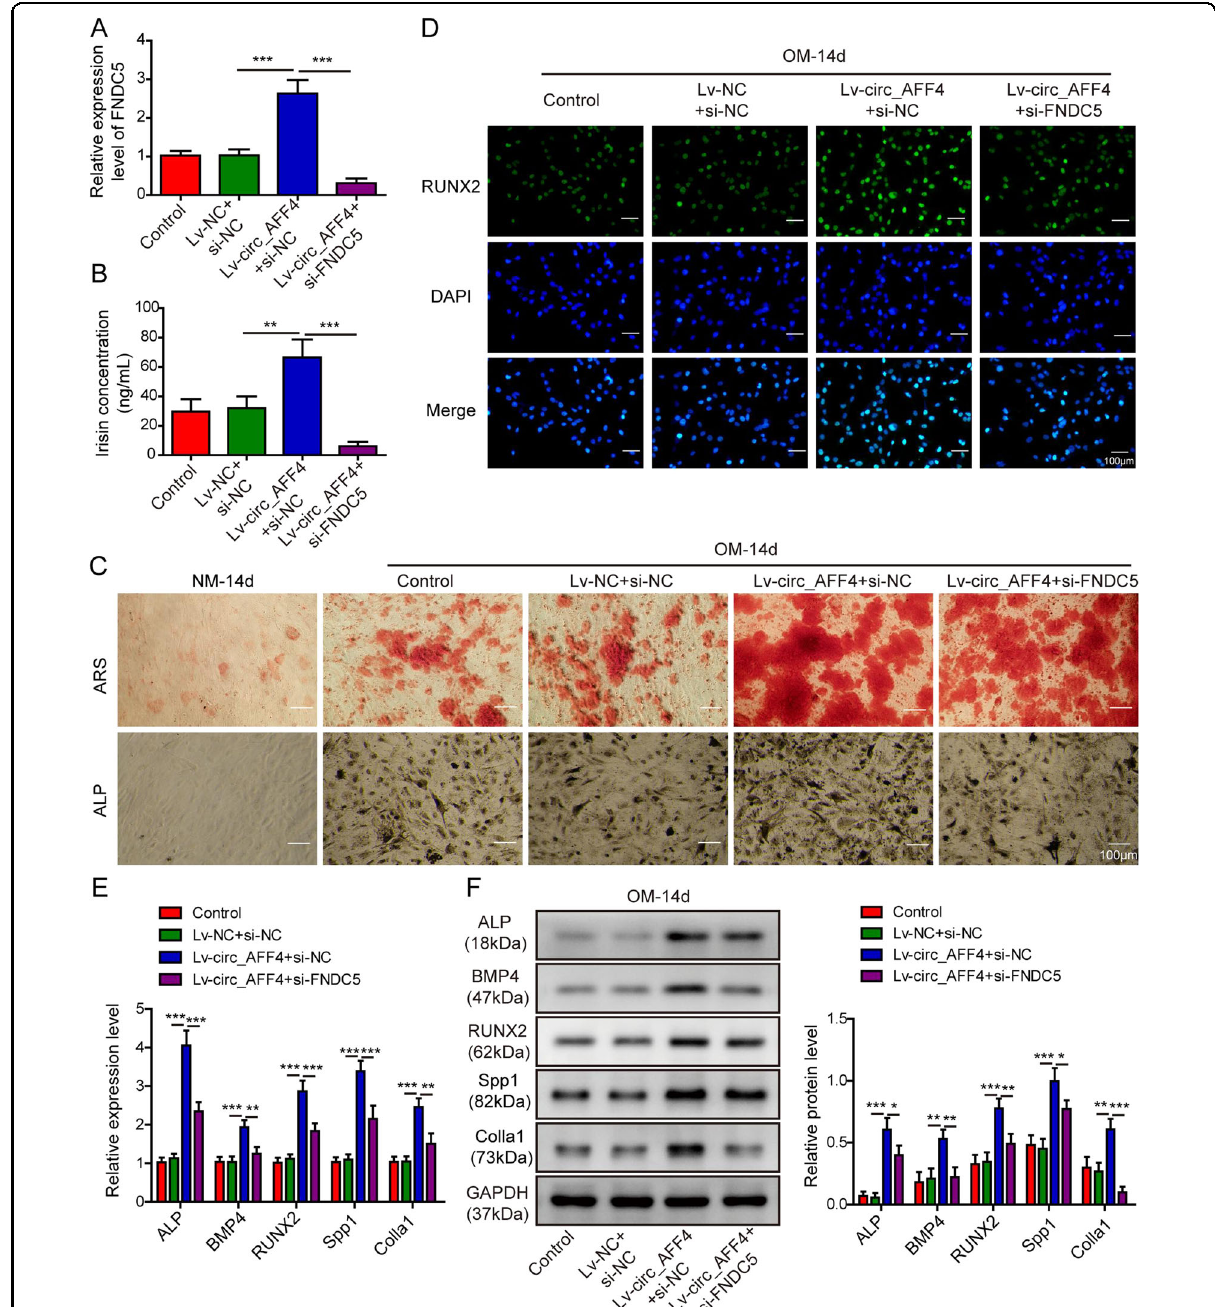
Fig. 5 Promotion of circ_AFF4 on osteogenic differentiation was partially reversed by silencing of FNDC5/Irisin. BM-MSCs were co- transfected with lentiviruses expressing circ_AFF4 and si-FNDC5 or negative control siRNA. A Relative expression of FNDC5 was detected by qRT-PCR. B Irisin concentration was determined by ELISA. C Transfected BM-MSCs were further cultured in OM or NM for 14 days. ARS and ALP staining assays were performed to analyze the osteogenic differentiation. D Transfected BM-MSCs were further cultured in OM for 14 days. RUNX2 expression was detected by immuno fl uorescence staining using RUNX2-speci fi c antibodies. qRT-PCR and western blot analyses were performed to evaluate the mRNA ( E ) and protein ( F ) expression of osteogenic marker genes ALP, BMP4, RUNX2, Spp1, and Colla1 in BM-MSCs. The data were shown as mean ± SD based on at least three independent experiments. * P < 0.05, ** P < 0.01, and *** P <